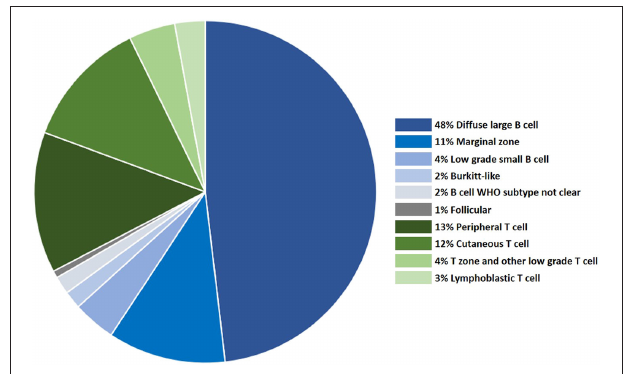
FIGURE 1 | The distribution of canine lymphoma categorized by WHO subtype, based on histology and immunophenotyping.